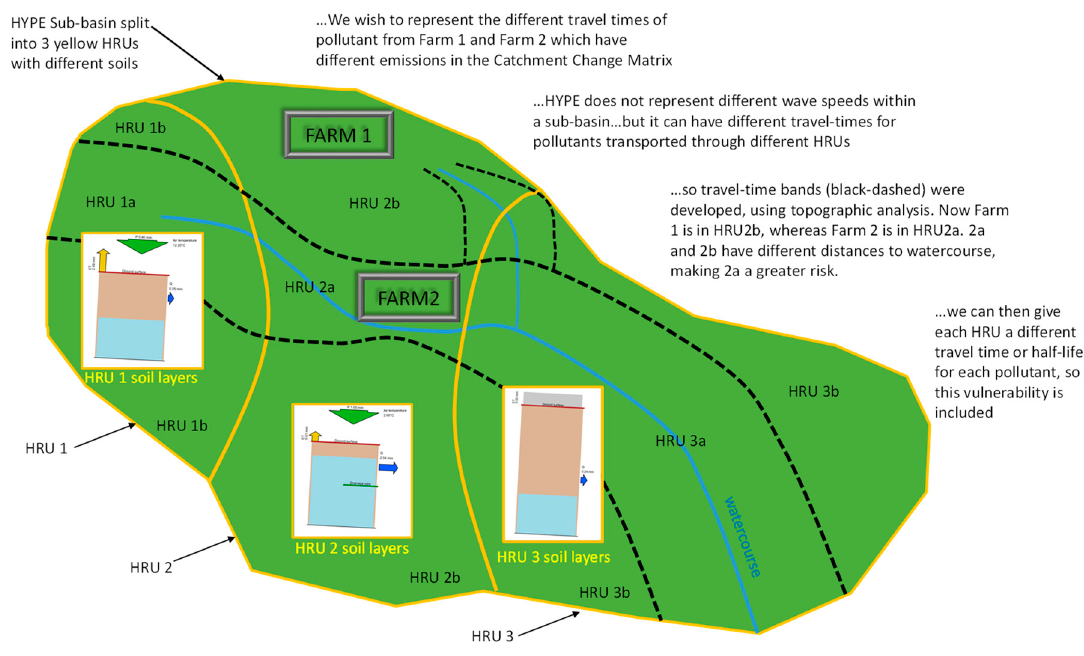
Figure 1. Schemetisation of new HYPE functionality.